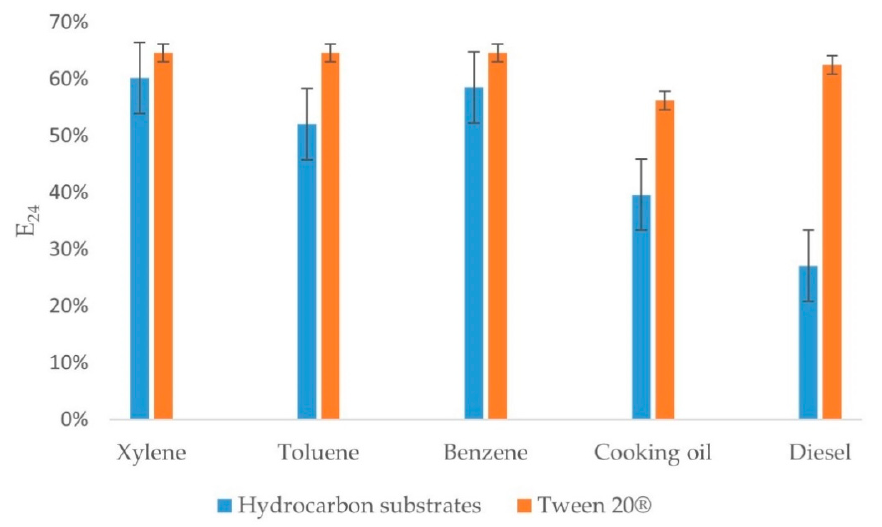
Figure 2. E 24 assay results on different hydrocarbon substrates, such as xylene, toluene, benzene, cooking oil, and diesel. Tween 20 ® (Sigma-Aldrich, Darmstadt, Germany) is used as the positive control. Error bars represent the standard deviation values of three independent measurements.